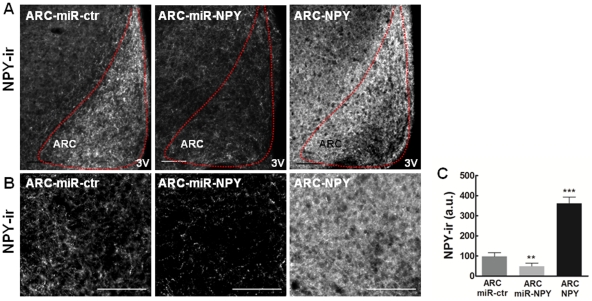
Modulation of NPY expression in the rat ARC via bilateral injection of AAV.(A) Representative images of NPY immunoreactivity (white) in the rat ARC modulated by AAV injection. Scale bar, 100 µm. (B) High magnification of representative images of ARC NPY immunoreactivity modulated by AAV injection. Scale bar, 100 µm. (C) Bilateral quantification of NPY immunoreactivity quantified through the rostro-caudal length of the rat ARC, eight weeks after AAV injection. ARC NPY immunoreactivity is 50% lower on the ARC-miR-NPY group and 3.6-fold higher on the ARC-NPY group, compared to ARC-miR-ctr group. n = 6 rats per group; ** p<0.01; *** p<0.001 compared to ARC-miR-ctr. ir, immunoreactivity.